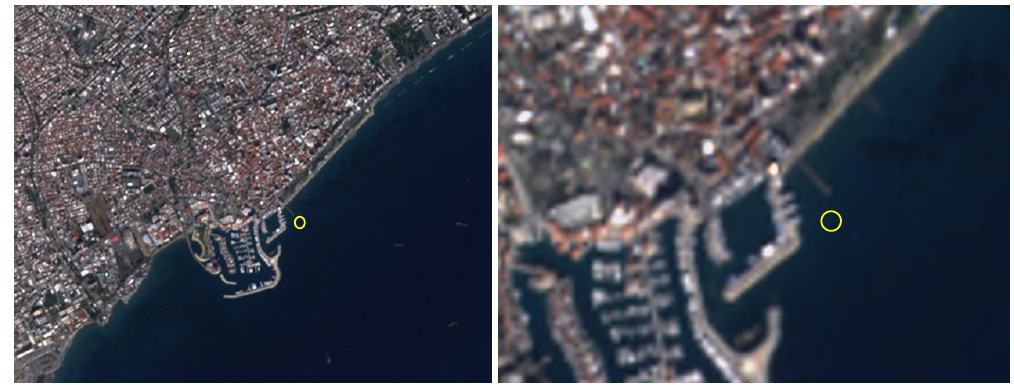
Figure 8. Sentinel-2 Satellite RGB image (15 December 2018). (Bands B04, B03, B02).